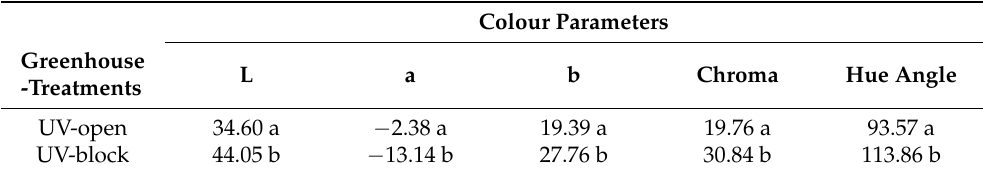
Table 3. Effects of greenhouse cover transparency in UV-A radiation on colour parameters (L, a, b, Chroma, and hue angle) of red lettuce (Redino Lollo rosso) as measured by colorimeter Minolta CR-400, 42 days after transplanting.